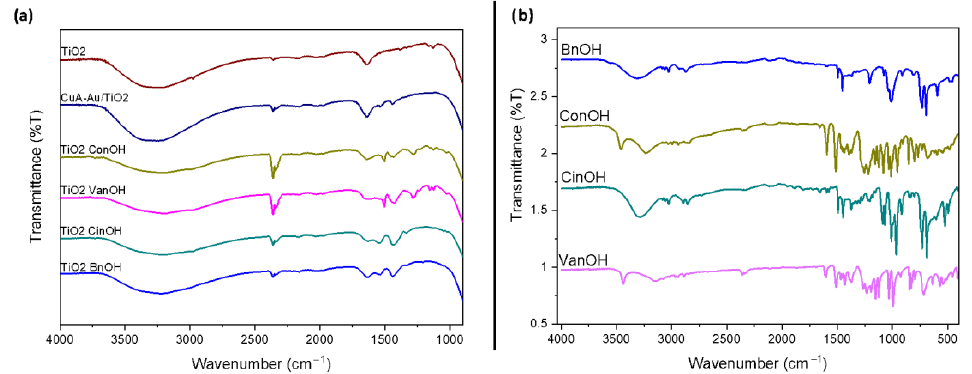
Figure 9. UV–visible diffuse reflectance absorption spectra of the TiO 2 and aromatic alcohol-adsorbed TiO 2 complex.